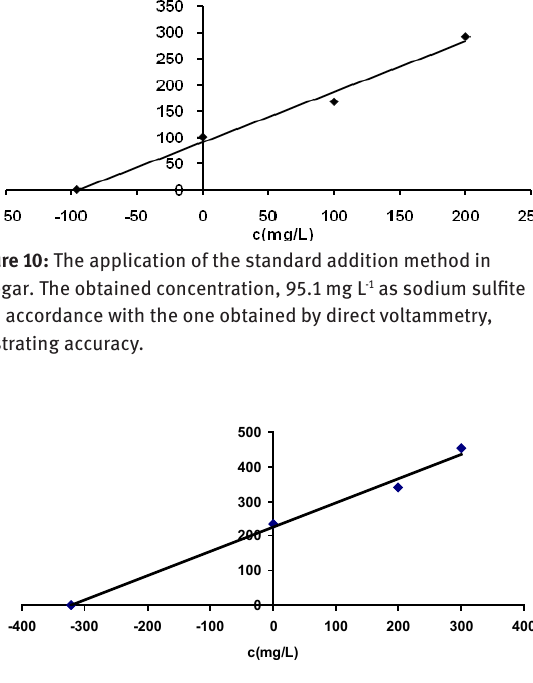
Figure 11: The application of the standard addition method in elderflower cider. The obtained concentration, 321.28 mg L -1 , as sodium sulfite, is in accordance with the one obtained by direct voltammetry,